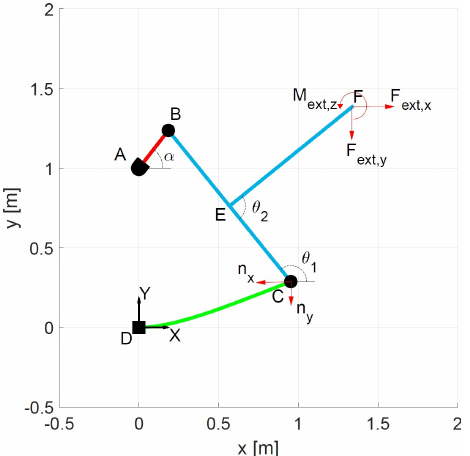
Figure 7. Analysed mechanism in an arbitrary